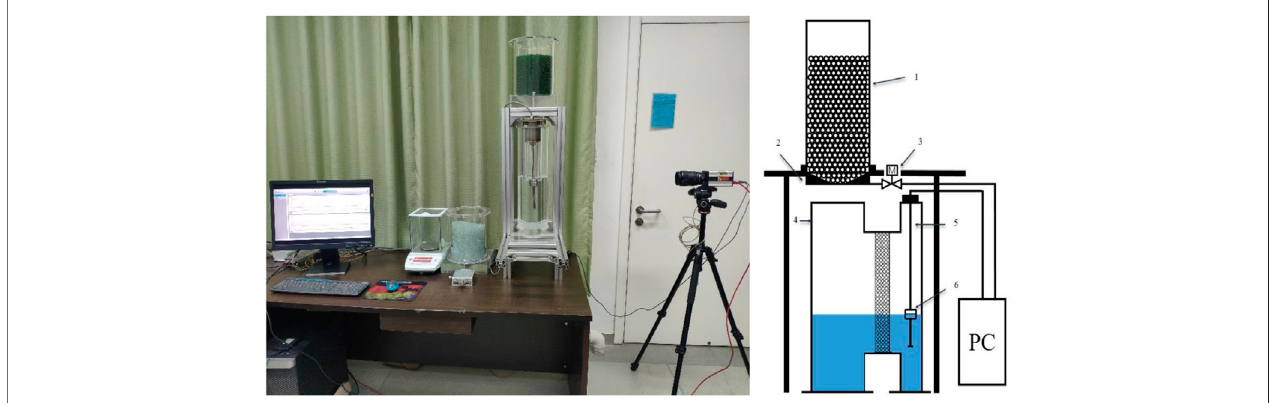
FIGURE 1 | Experimental setup 1-cylindrical silo; 2-conical hopper; 3-electric gate; 4-bucket; 5-container; 6-level sensor.